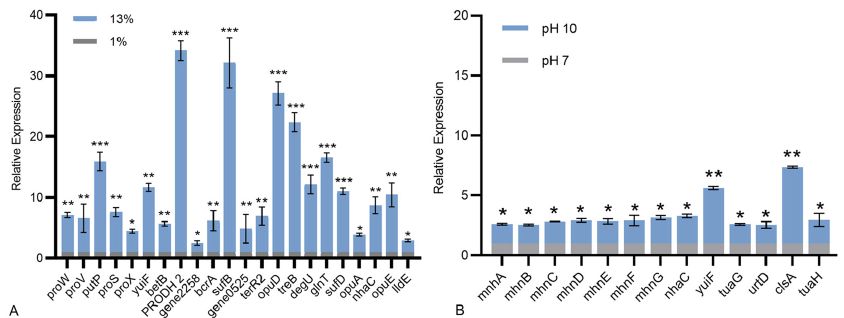
Figure 7. Relative expression levels of different genes involved in stress resistance. ( A ) The relative expression levels of different genes in B. halotolerans KKD1 grown at 1% and 13% salinity. ( B ) The relative expression levels of different genes in B. halotolerans KKD1 grown at pH 7.0 and pH 10.0. Data are the average thickness ± the standard deviation (SD) of three independent experiments. *, indicates a significant difference ( p < 0.05 ), **, indicates an extremely significant difference ( p < 0.05 ), ***, indicates an extremely significant difference ( p < 0.01 ) compared to that of control group.